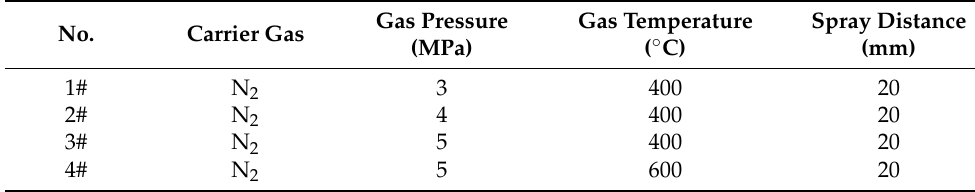
Table 1. Process parameters for cold spray of Al